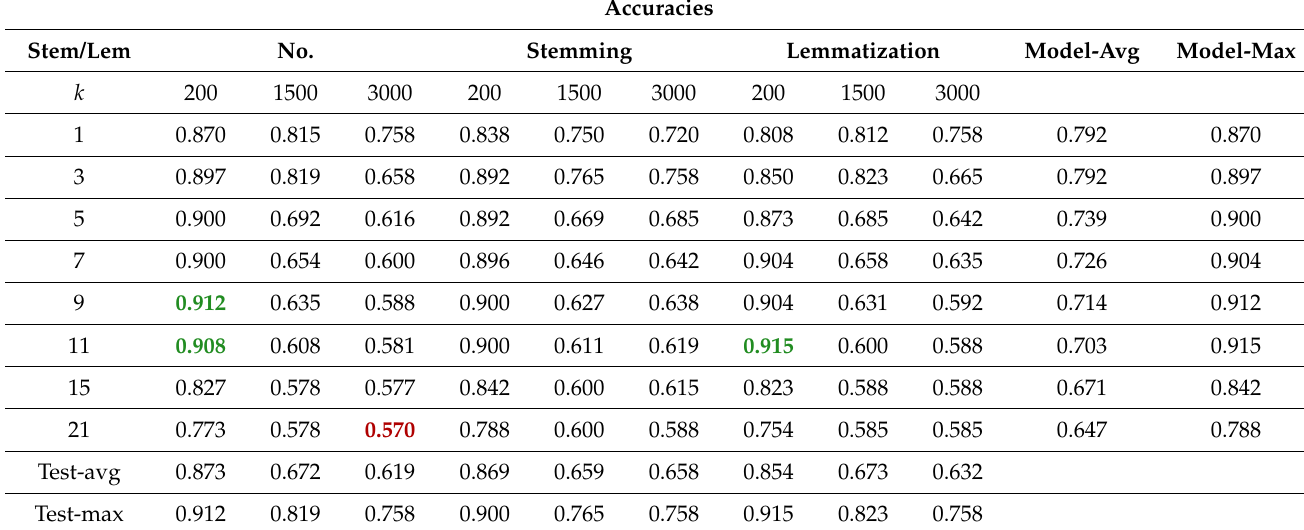
Table A2. Accuracies obtained in Substage 2